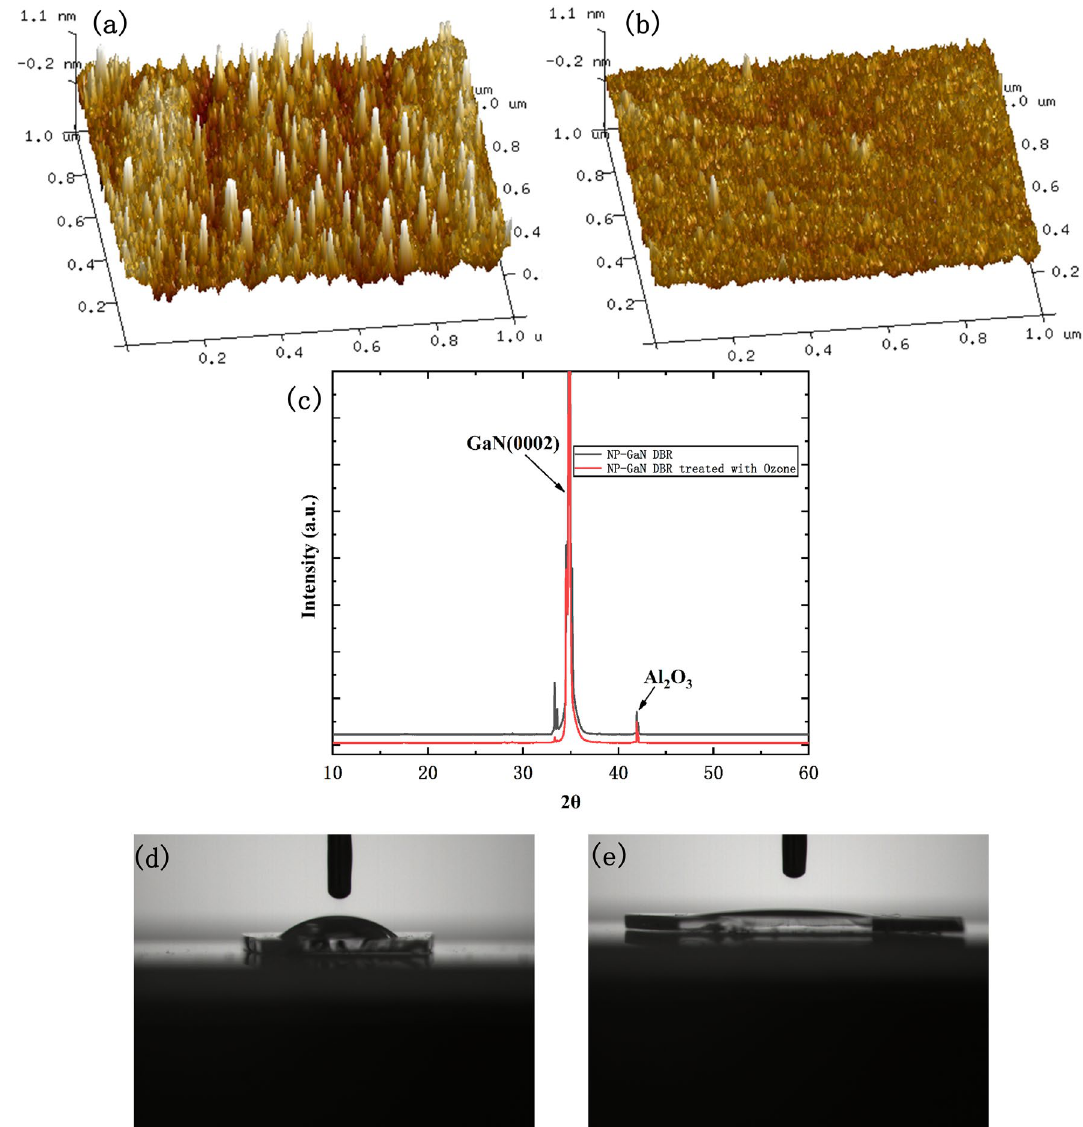
Figure 3. The AFM surface micrograph of the NP-GaN DBRs ( a ) untreated and ( b ) treated by ozone. ( c ) The XRD patterns of the NP-GaN DBRs untreated and treated by ozone. The contact angles between the NP-GaN DBR and the precursor solution ( d ) untreated and ( e ) treated by